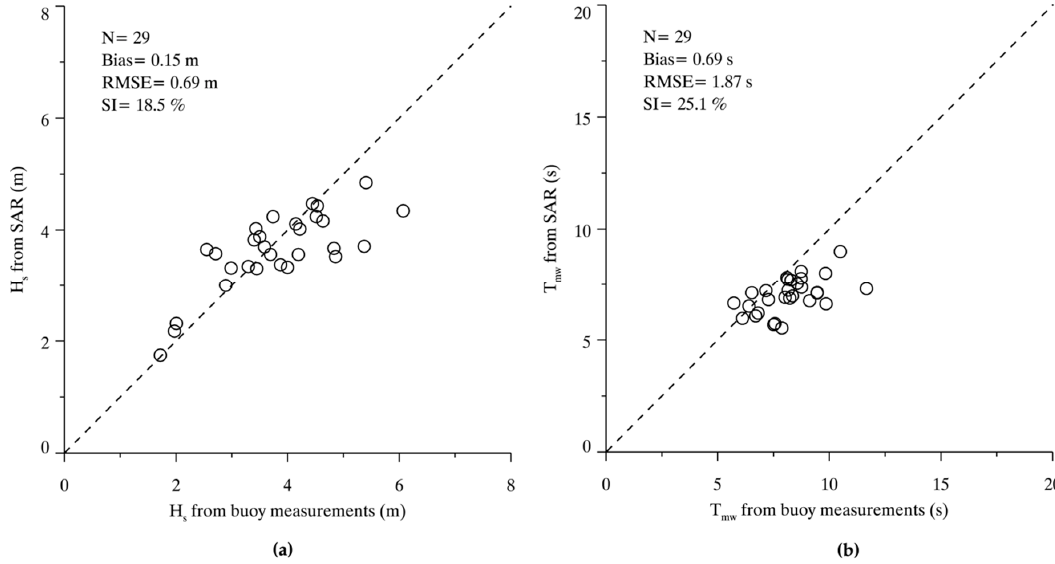
Figure 10. Wave parameters retrieval results from 29 wind-sea dominant cases are compared to buoy measurements. ( a ) H s comparison; and ( b ) T mw comparison.